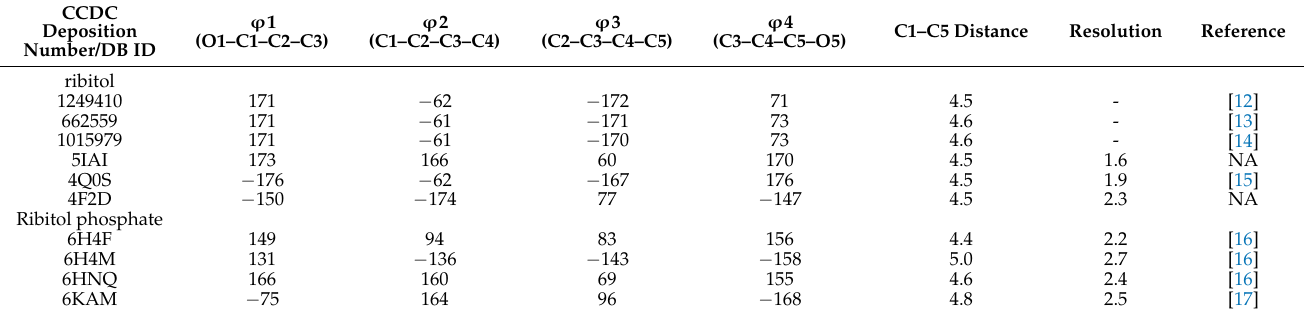
Table 1. Main chain dihedral angles ( ° ), C1–C5 distance ( Å ), and resolution (Å) of ribitol and ribitol phosphate extracted from the CCDC and the PDB. NA; not available.